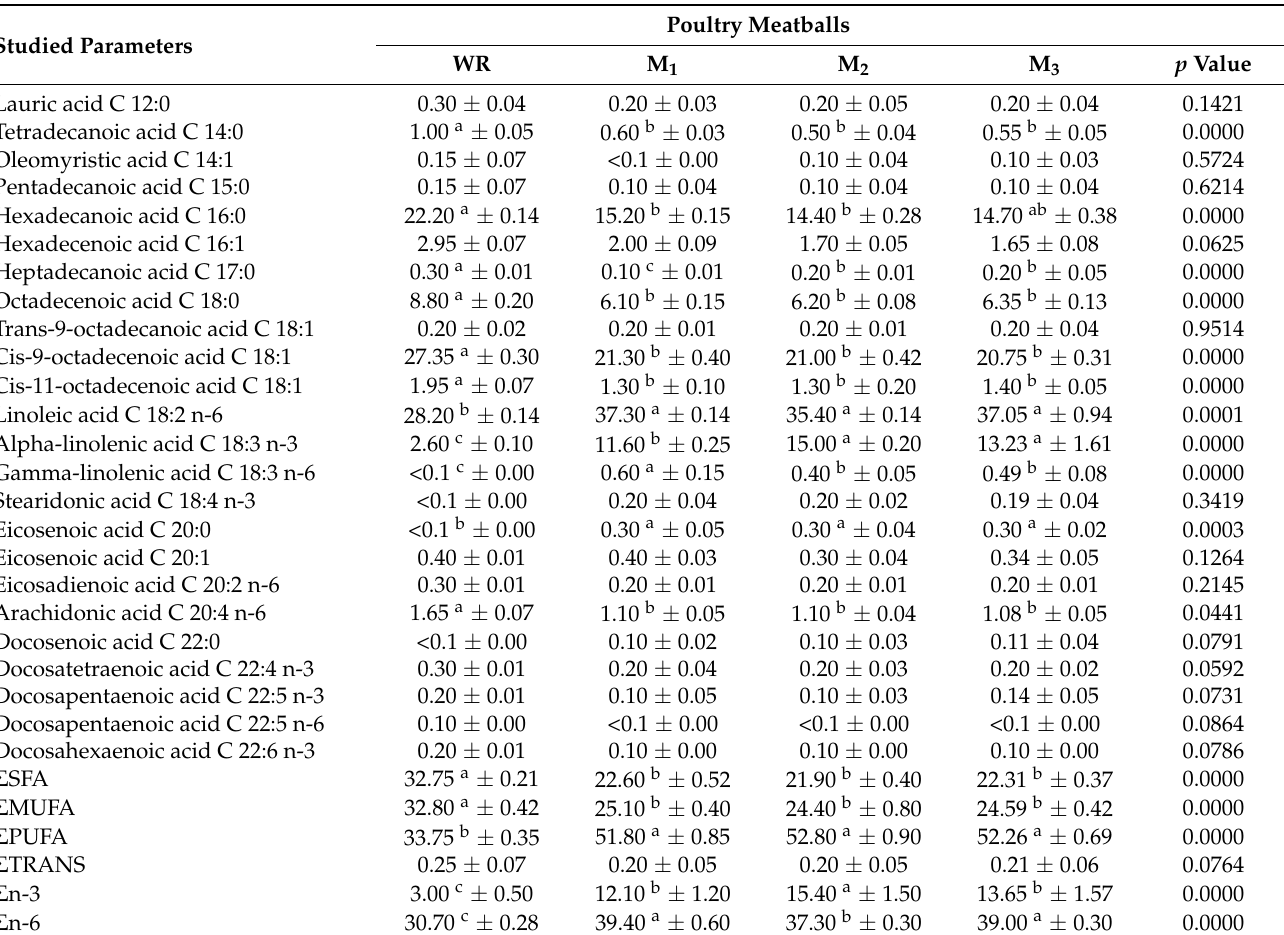
Table 4. Effect of adding a mixture of linseed, amaranth and hemp seeds on the fatty acid profile of poultry meatballs